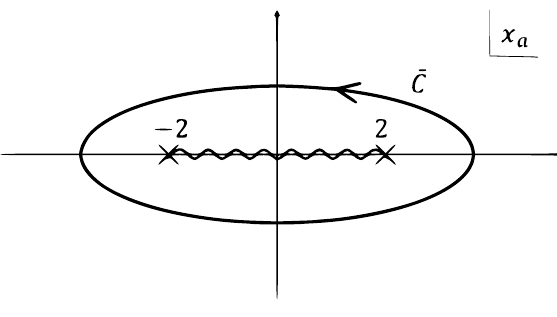
Figure 2 . Integration contour ~ C on the complex x a